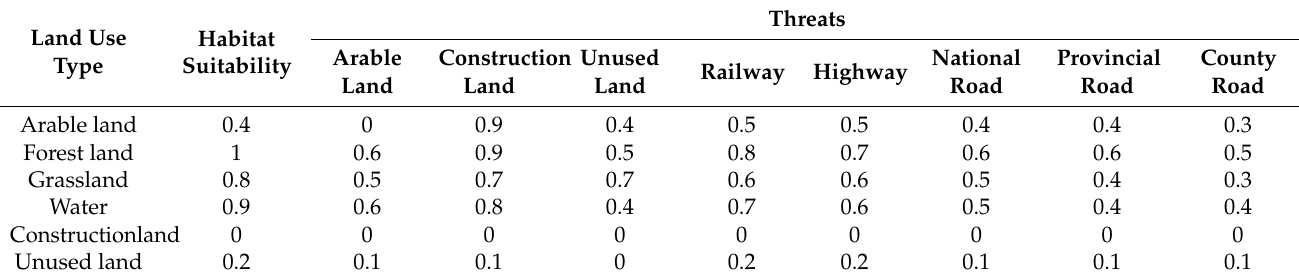
Table 2. The habitat suitability and sensitivity of land use type to each threat